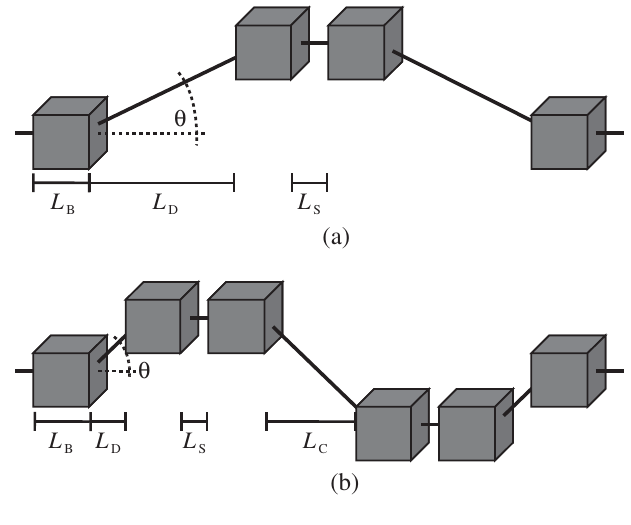
FIG. 1. C-chicane (a) and S-chicane (b).*Electronic address: